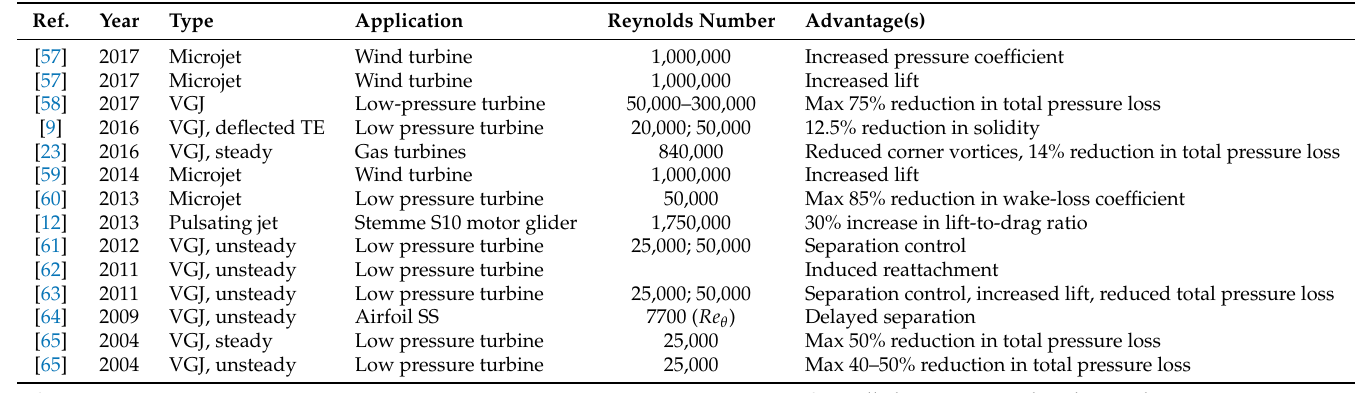
Table 5. Representative summary of vortex generator jet